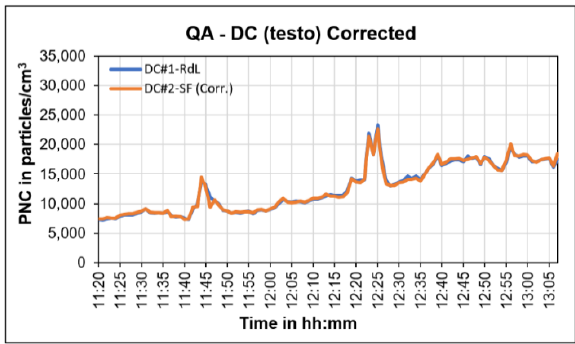
Figure 30. DC#1 and corrected DC#2 graphs.